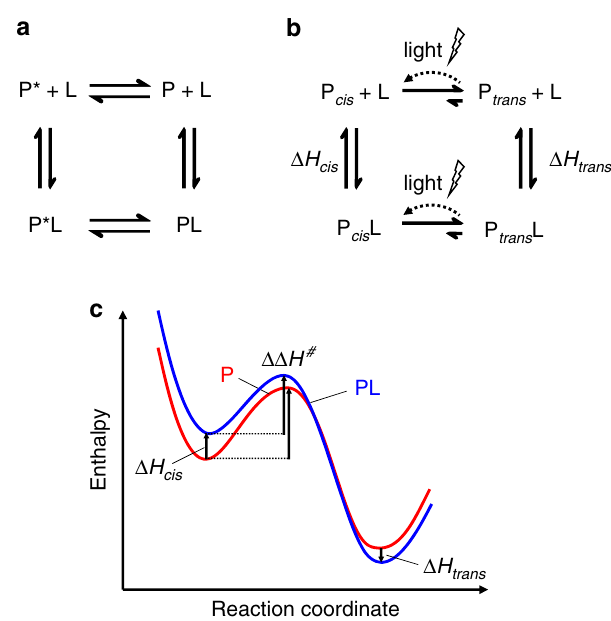
Fig. 4 Thermodynamic cycles. a Conventional thermodynamic cycle of the two-state model of allostery with P and P * being resting and active states of the protein, and P + L and PL the apo and ligand-bound states, respectively. In contrast, b the thermodynamic cycle of the photoswitchable system, where the cis -to- trans reaction is essentially unidirectional, but can transiently be put out of equilibrium by light, as indicated by the fl ash and the curved dotted arrow. c Energy pro fi les (not on scale) of the thermal cis -to- trans isomerisation of the free protein P (red) or the ligand bound protein PL (blue). relevant. Figure 4c compiles the energetics of the cis -to- trans